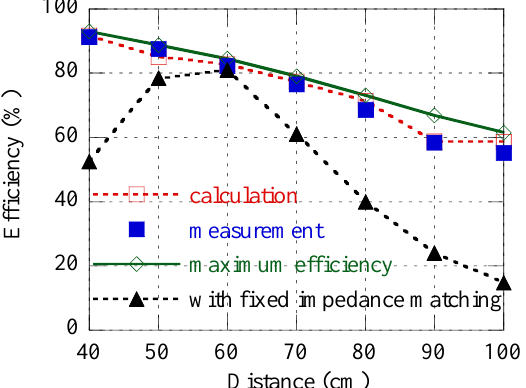
Figure 9. Measured and calculated power transfer efficiencies with optimal impedance matching, theoretical maximum power transfer efficiency ( η max ), and measured power transfer efficiency with the impedance matching condition fixed at D = 60 cm ( N p 1 opt = N p 2 opt = 4).